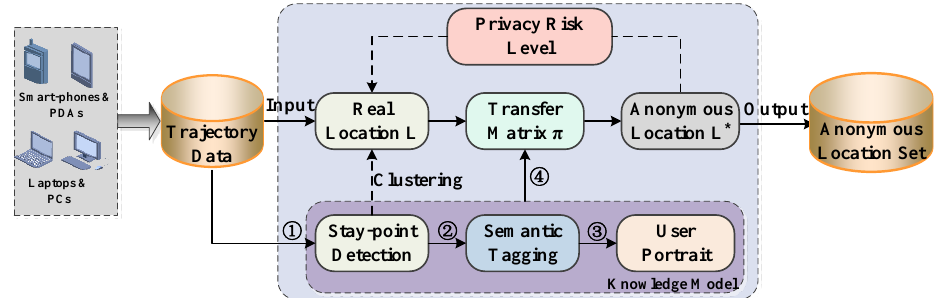
Figure 1. The workflow of KD-LPP scheme. ① Initialization